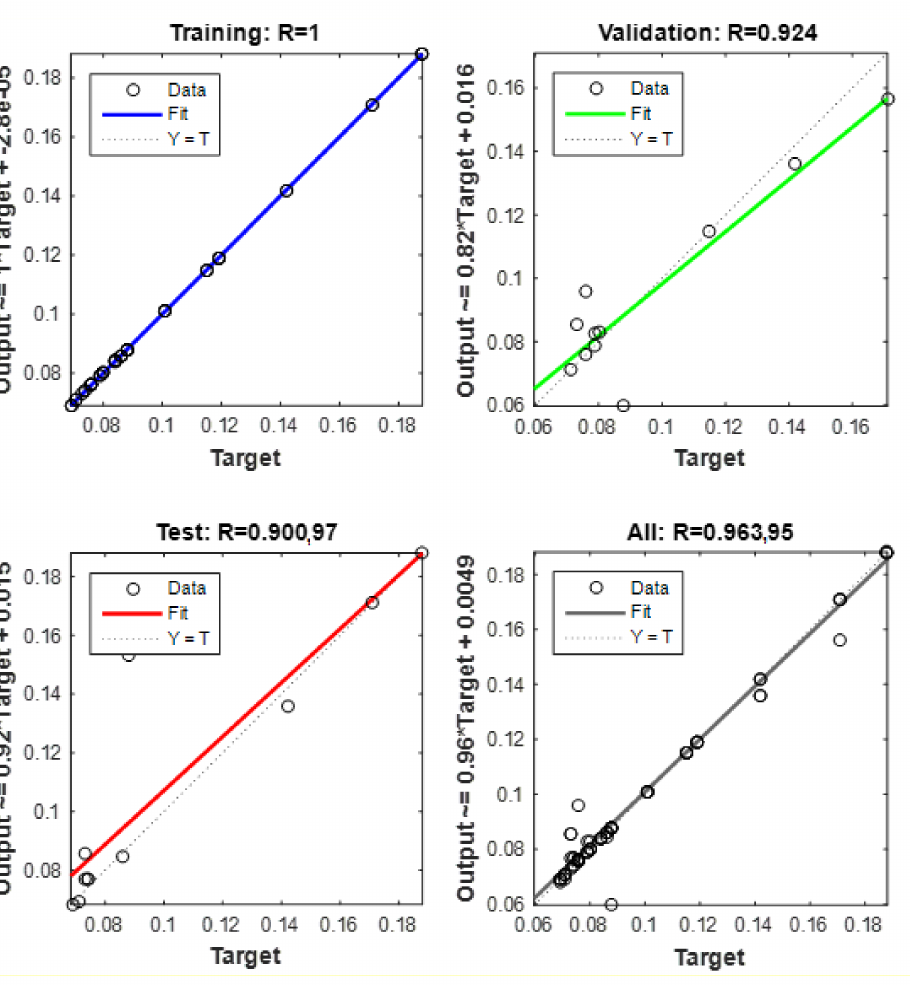
Figure 4. Regression analysis (by the